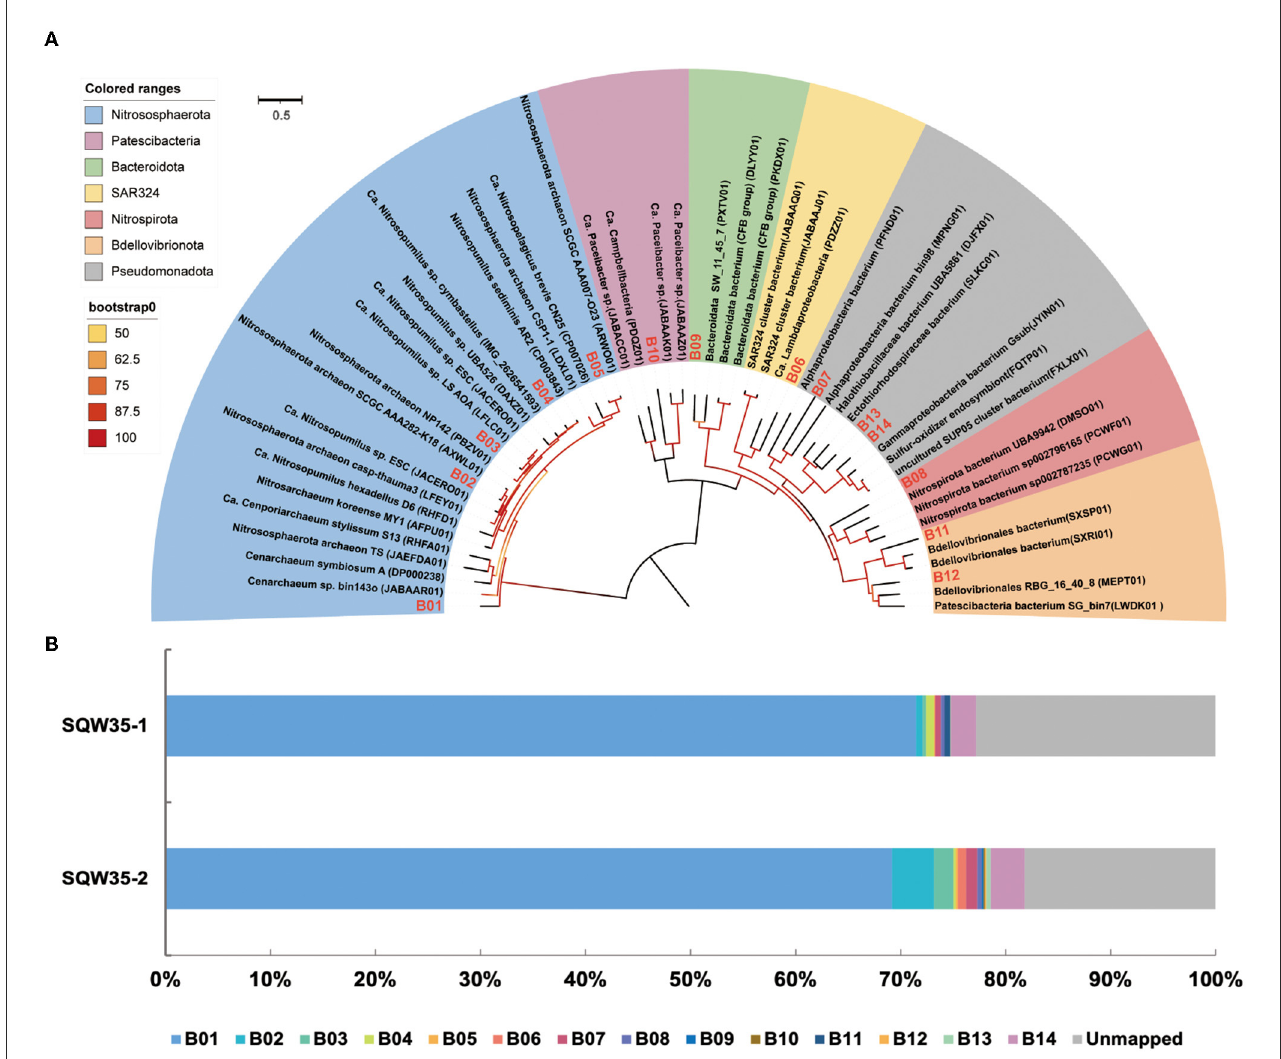
FIGURE2 Phylogenomic tree of sponge-associated MAGs and their relative abundance. (A) Phylogenomic maximum-likelihood tree of the 14 sponge-associated MAGs was constructed using the “LG + F + R7” model. Sponge-associated MAGs of Bathydorus sp. SQW35 are marked with red in the tree. All the reference genomes are listed in Supplementary Table 12. (B) Relative abundance of sponge-associated MAGs in the metagenomes of Bathydorus sp. SQW35. The relative abundance of MAGs was calculated with coverM v0.2.0 using metagenome reads after eliminating reads assigned to eukaryotic